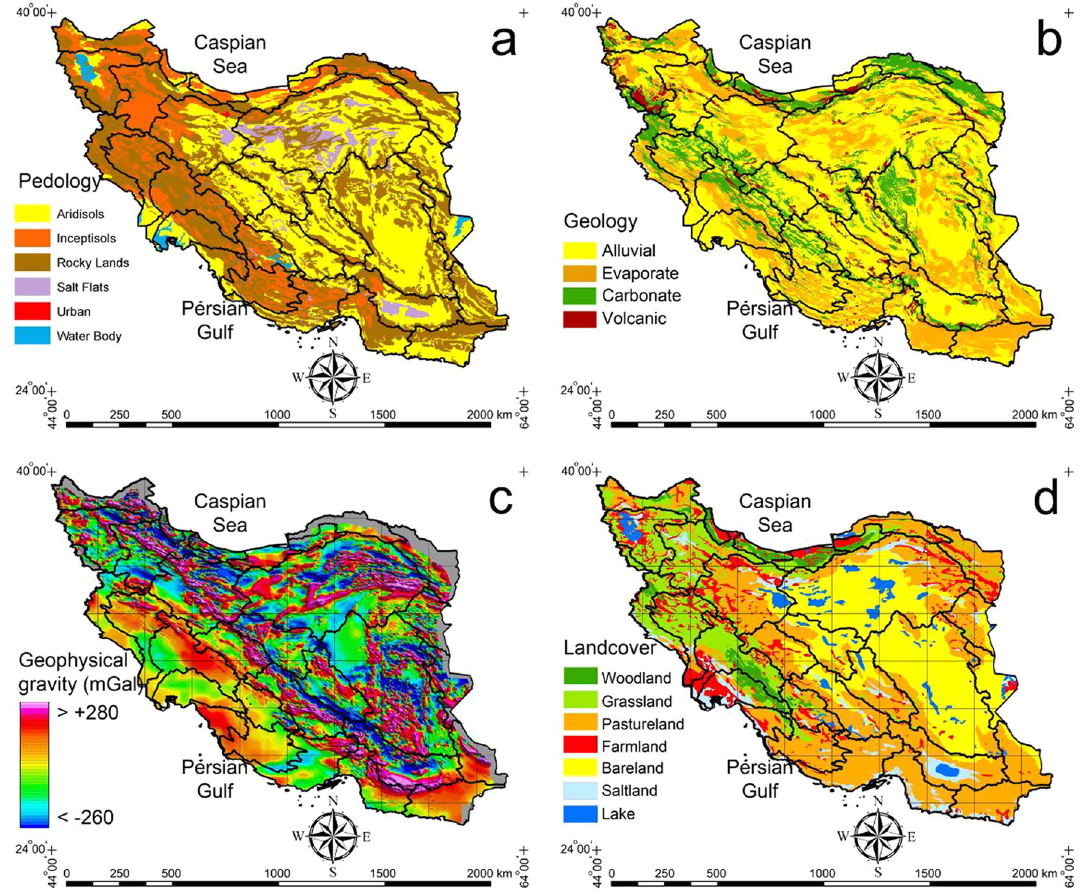
Fig. 3 Input environmental variables to efficiency assessment of the construction of the Qanat water system including a . geology (major land- forms), b . pedology (major soil units), c . geophysical gravity, and d . land-cover